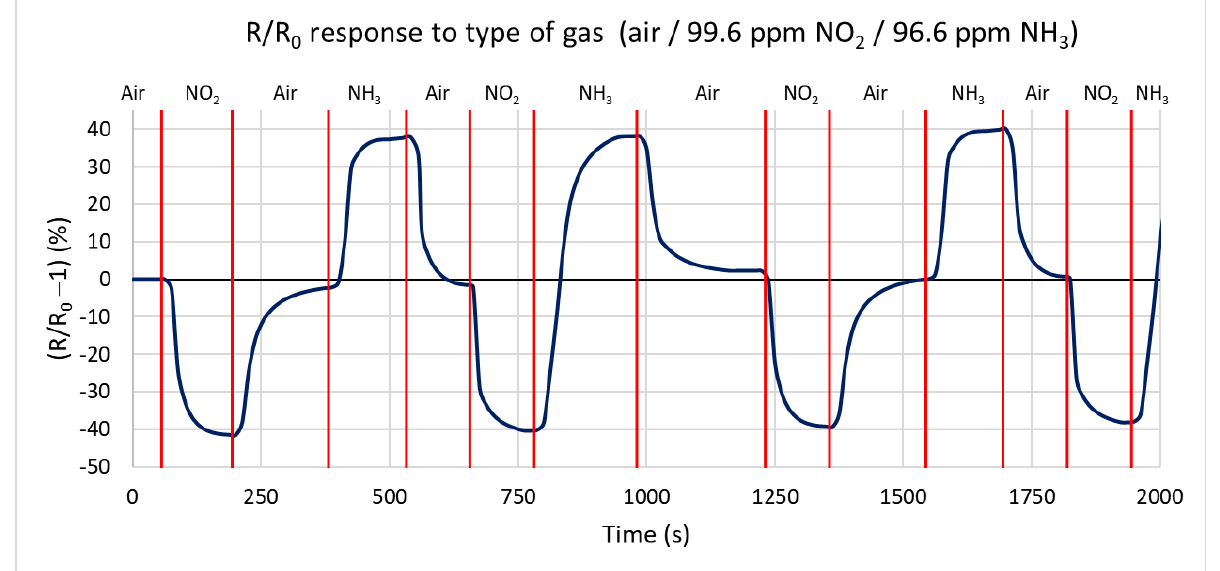
Figure 10. Time dependence of H-terminated NCD sensor’s response to three types of gases (ammonia, nitrogen dioxide, and synthetic air) at 125 °C with a gas flow rate of 100 sccm.